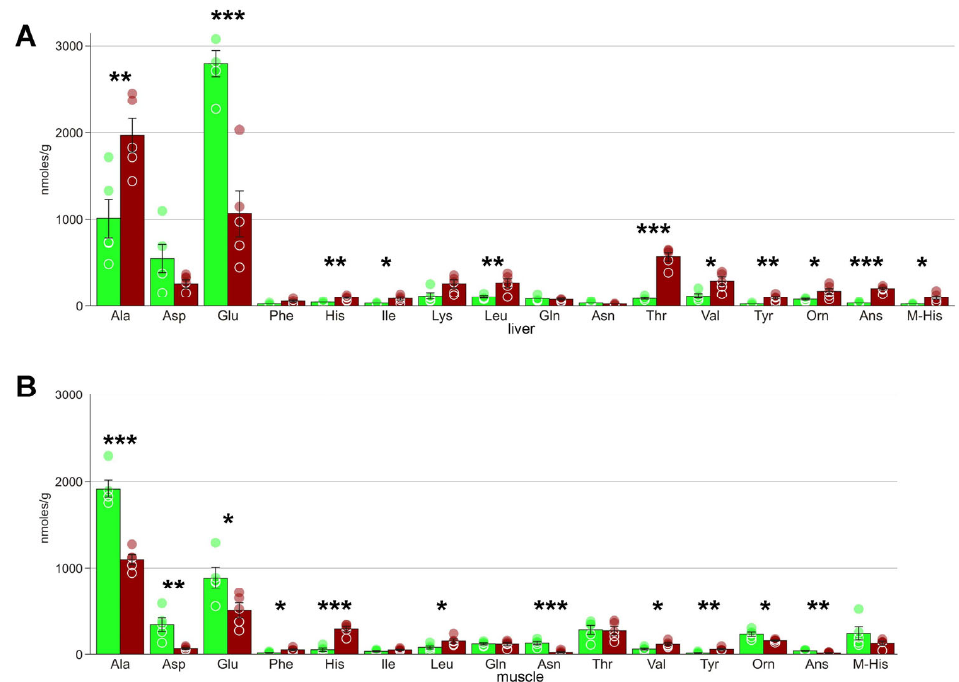
Figure 6. Concentrations of amino acids: ( A ) liver; ( B ) muscles. Green columns, control; red, frozen; * Welch test p < 0.05; ** p < 0.01; *** p < 0.001; circles, individual data points; bar, SE.